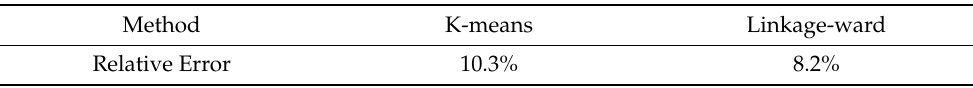
Table 9. Relative error between cluster members and their centers in different methods